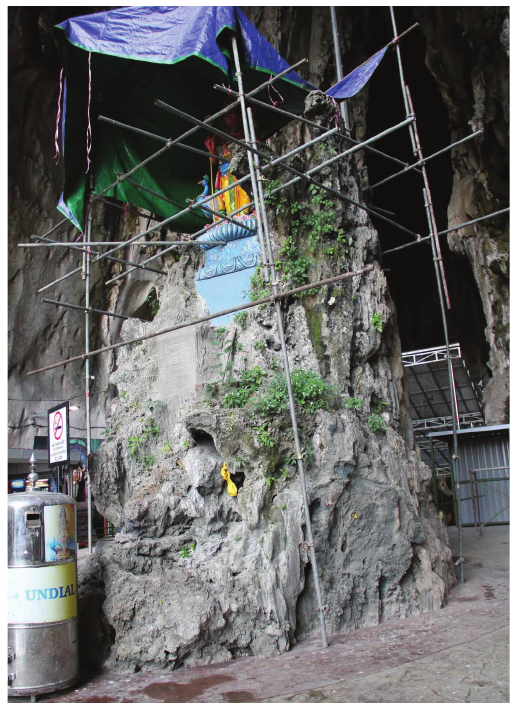
Figure 6. The type locality of Impatiens ridleyi (Balsaminaceae) in